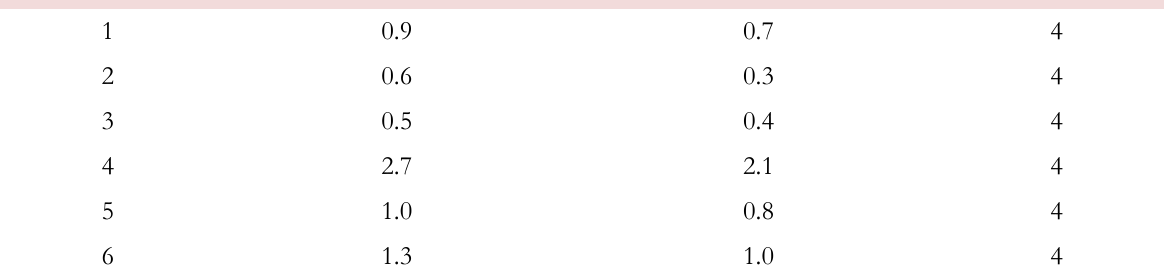
Loading condition